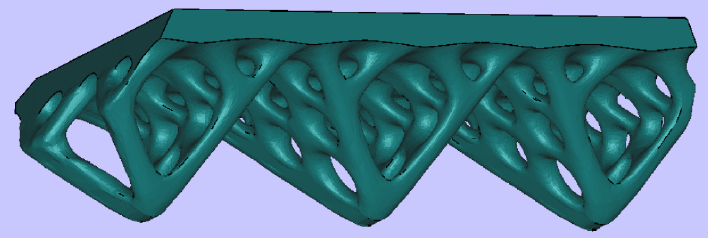
Figure 8. Self-supporting tree structure for upper thermal plates to overcome the problem of fabricating horizontal planes by PBF-LB/M.